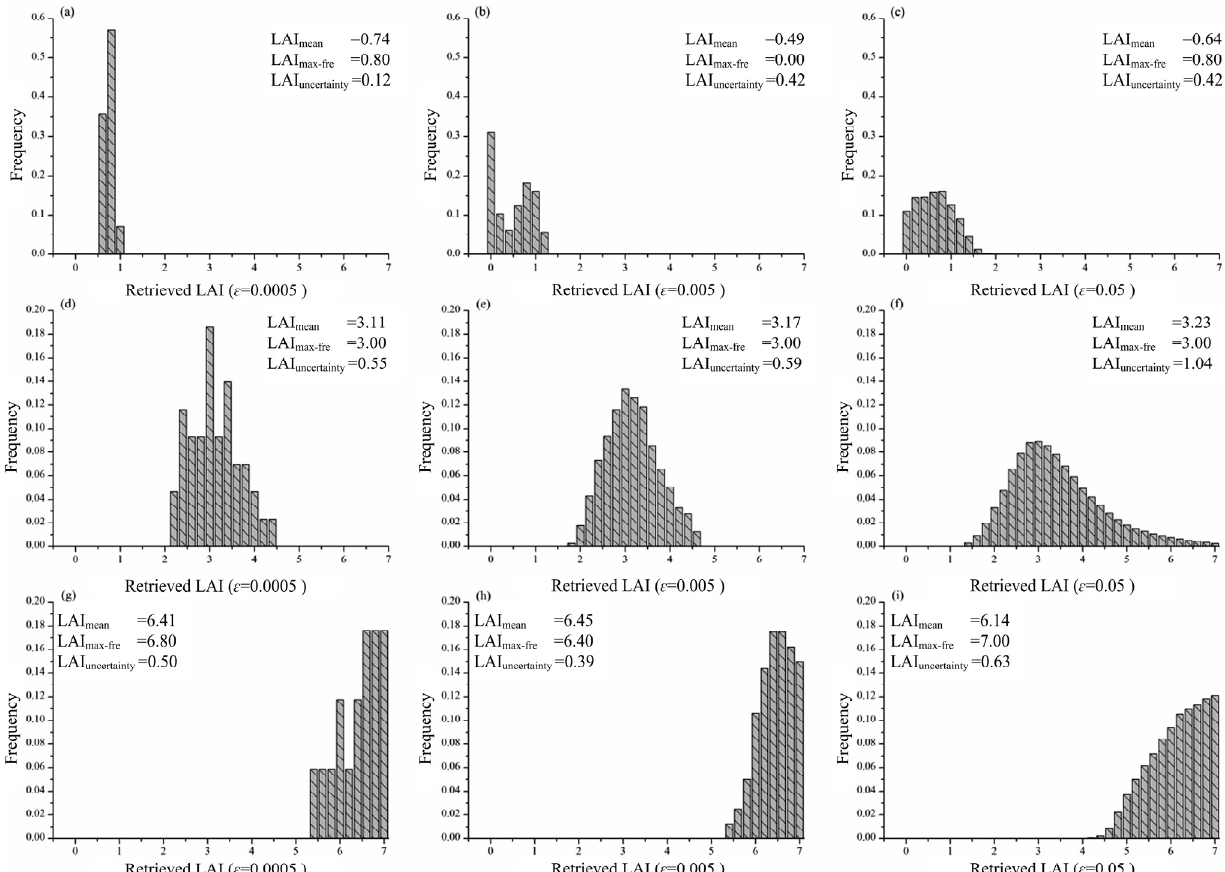
Figure 4. Distribution of LAI r . Because of the ill-posed inversion problem, LAI r is not a single value but a wide range of different frequencies.